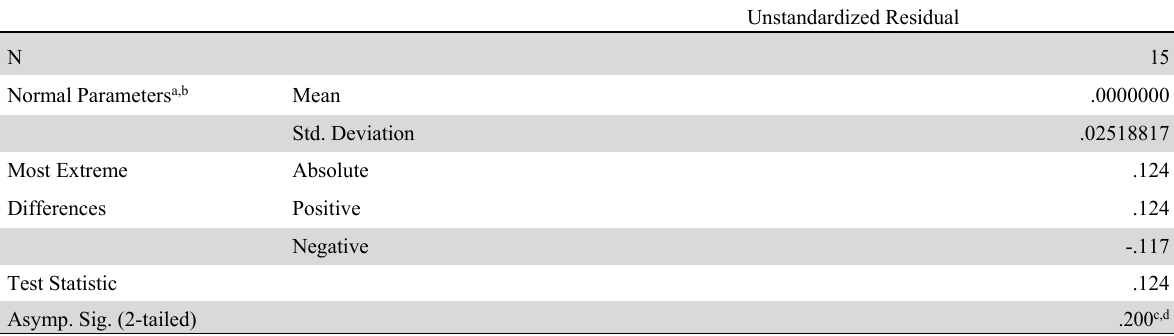
One-Sample Kolmogorov-Smirnov Test